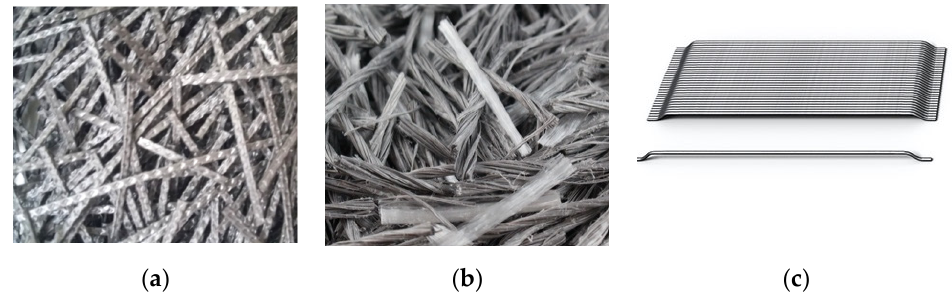
Figure 1. Photos of the fibers used in the study: ( a ) type P1; ( b ) type P2; and ( c ) type S.